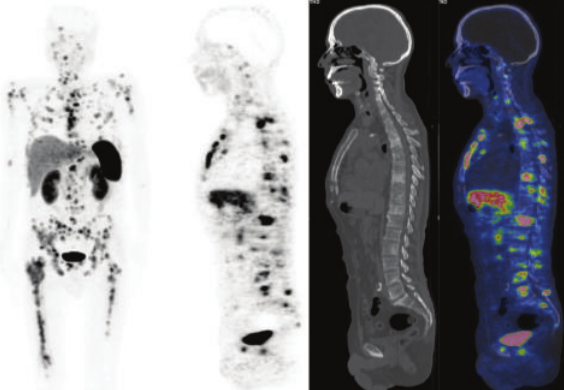
Figure 4: 68 Ga-DOTATOC PET/CT images (MIP, sagittal) in a patient with metastatic small cell lung